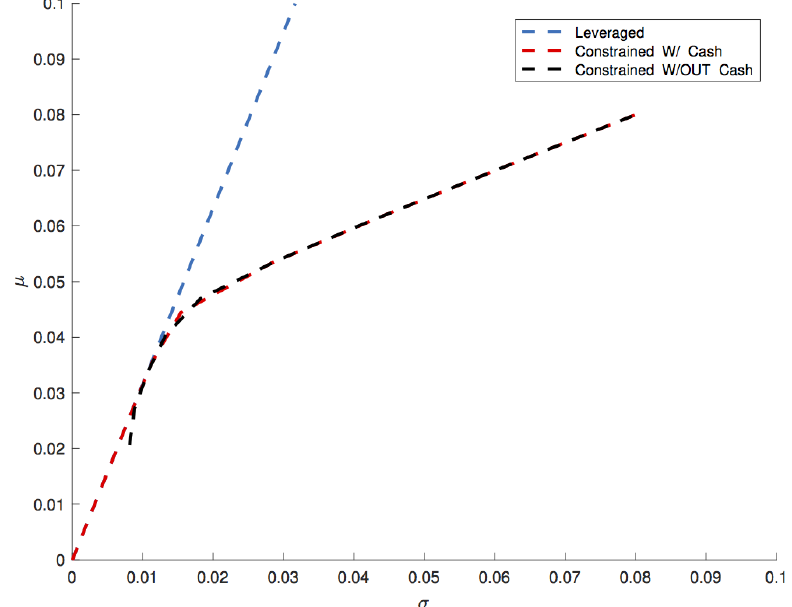
Figure 1. Comparison between leveraged portfolio with the classical Markowitz’s portfolio with the statistical hypotheses of Equations (41) and